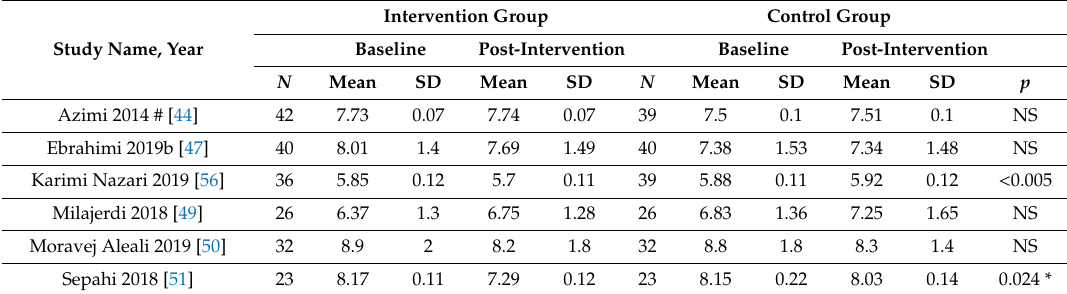
Table 3. Summary of findings for glycated